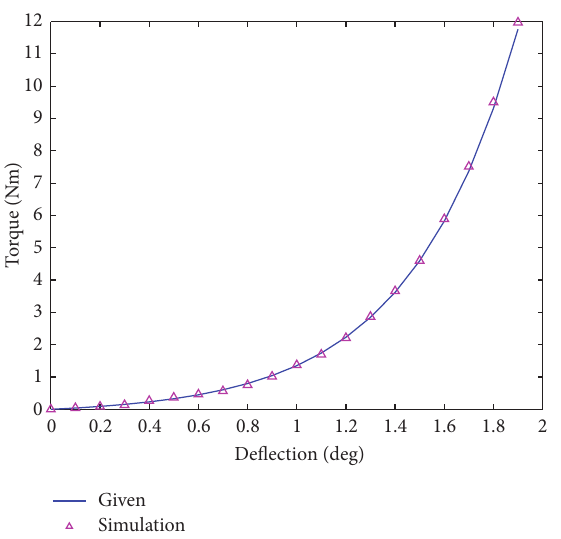
Figure 7: Compensated torque-deflection trajectory.